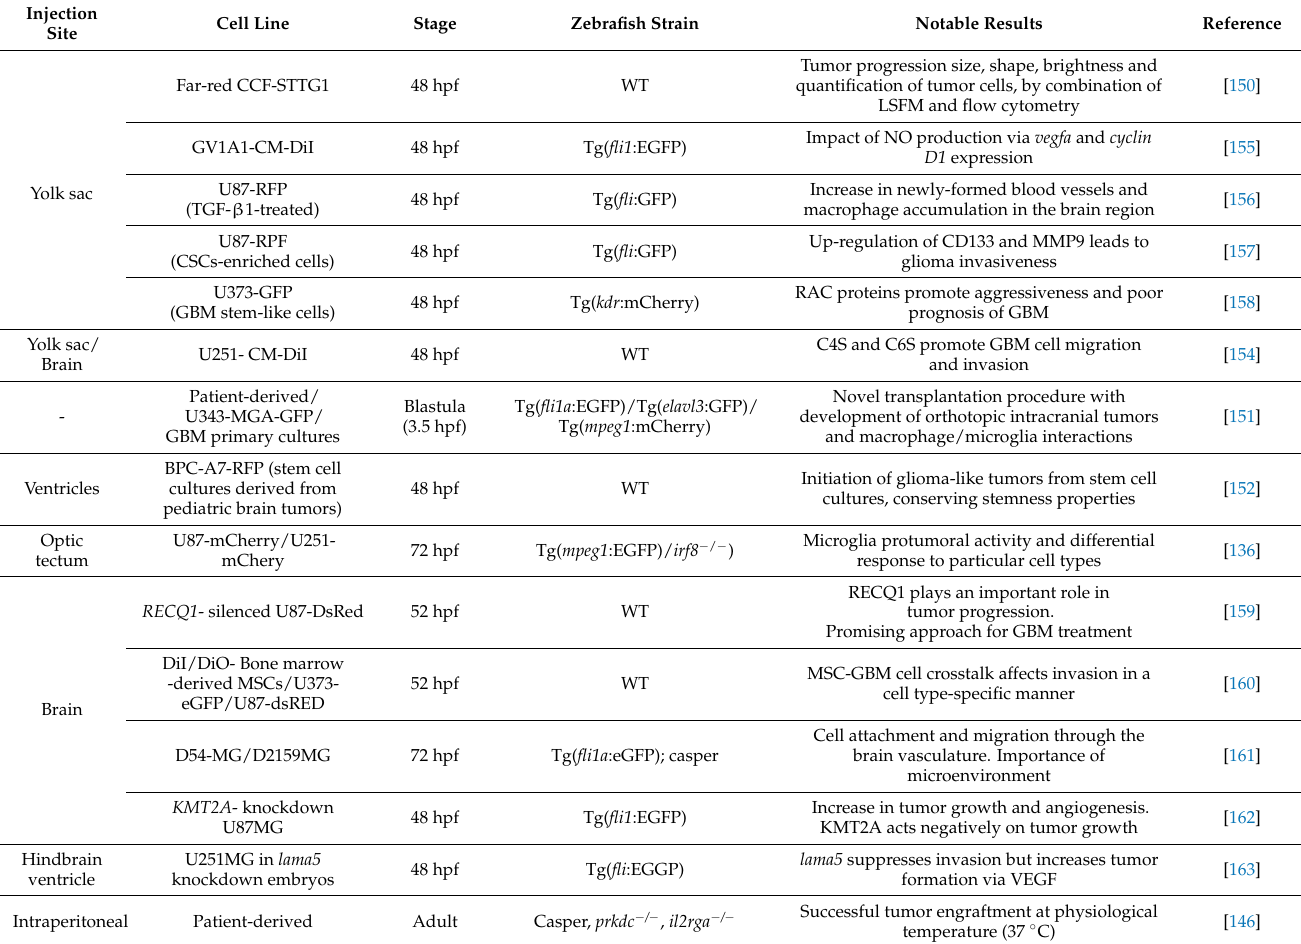
Table 2. Xenograft approaches using zebrafish for modeling